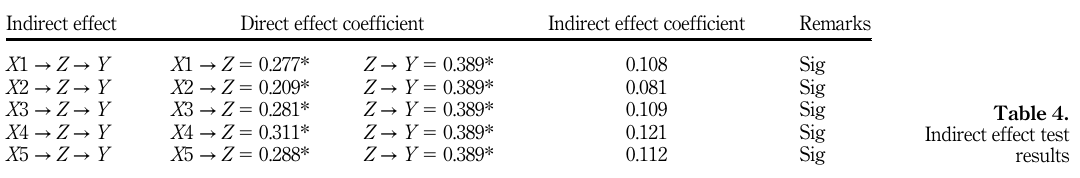
Table 4. Indirect effect